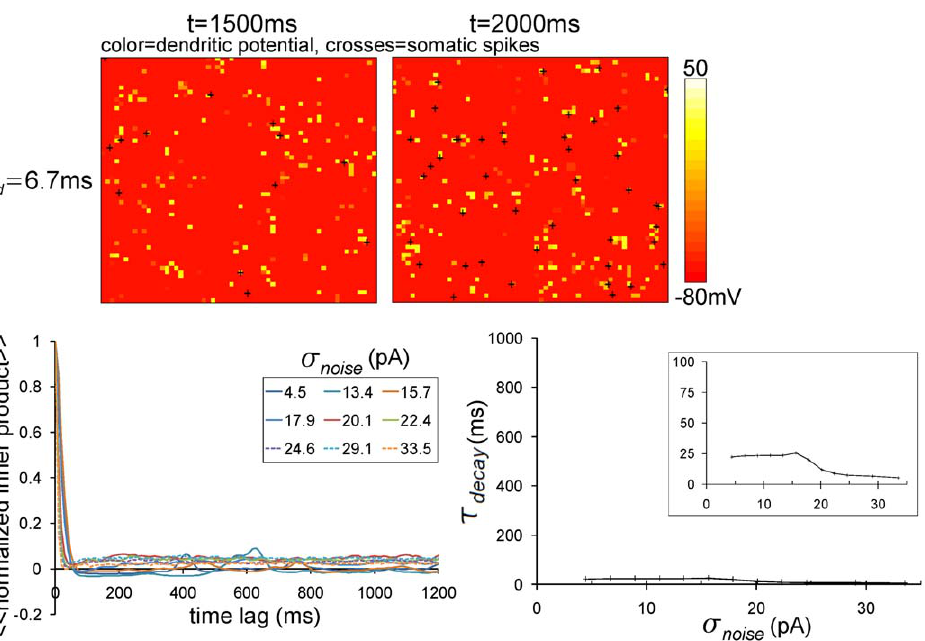
Figure 4. Bump is broken in noisy background condition without slow dendritic dynamics. (A) Snapshots at t ~ 1500 ms (leftmost) and 2000 ms (center) of noisy background inputs ( s noise ~ 22 : 4 pA) with fast dendritic dynamics ( t d ~ 6 : 7 ms). No bump was observed. (B) The decay of the inner product with the time lag depends on the noise intensity, s noise . The left panel shows the decay curves of the inner product with the time lag for various values of s noise . The curves presented are obtained with the temporal and trial average of the time lag-dependent inner products expressed by SS : TT . The right panel shows the dependence of the decay time constant calculated by curves of the inner product on s noise . Inset: a close-up view. In this case, the inner products decay very rapidly in large values of s noise and any immobilization is not observed. t d ~ 6 : 7 ms. Figure 5A, upper, deliver driving currents isotropically due to its symmetric innervation (see Figure 1A). However, the currents delivered in the tail direction cannot elicit spikes because the long tail of the somatic K z current distribution inhibits it. On the other hand, the currents delivered in the head direction can easily elicit new somatic spikes because there is a fresh field free from refractory currents at the head. Thus elicited new spikes drive the bump in the direction in which it has been moving. Importantly, the movement keeps the somatic K z current distribution spatially biased, while the spatial bias keeps the bump moving, resulting in a self-regenerative loop (Figure 5E). Thus, once it has started moving, the bump keeps moving. This observation corresponds well to what happens in the point neuron model [46], and in this bump movement, the delayed refractoriness of somatic but not dendritic K z currents plays a major role.